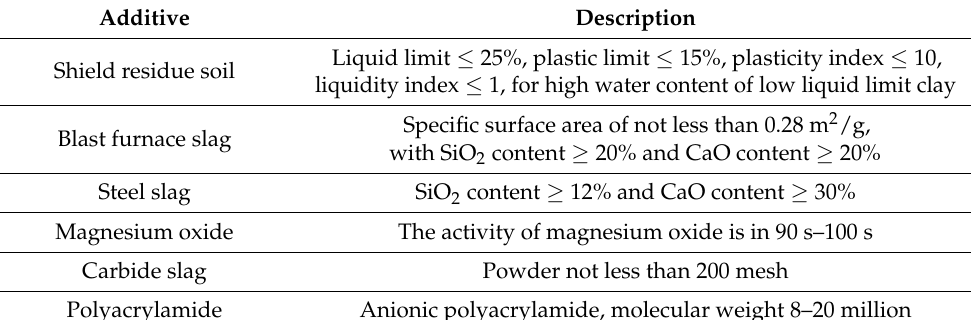
Table 6. The low-carbon material in this